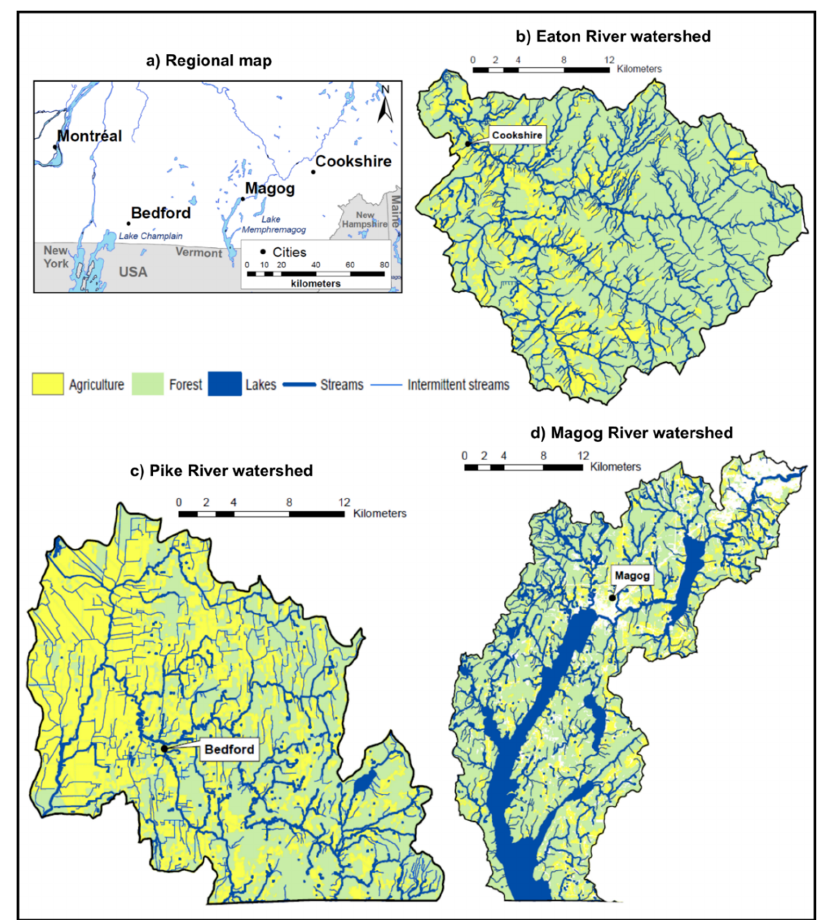
Figure 1. ( a ) Regional map of the study area indicating important cities in the studied watersheds; ( b – d ) Maps of the studied watersheds indicating agricultural and forest land use, and hydrological network. Elevation (asl) is 85 m at Bedford, 215 m at Magog and 240 m at Cookshire. Table 1. Watershed area occupied by annual and perennial crops and pastures in 2014 for the three studied watersheds in Southern Québec.